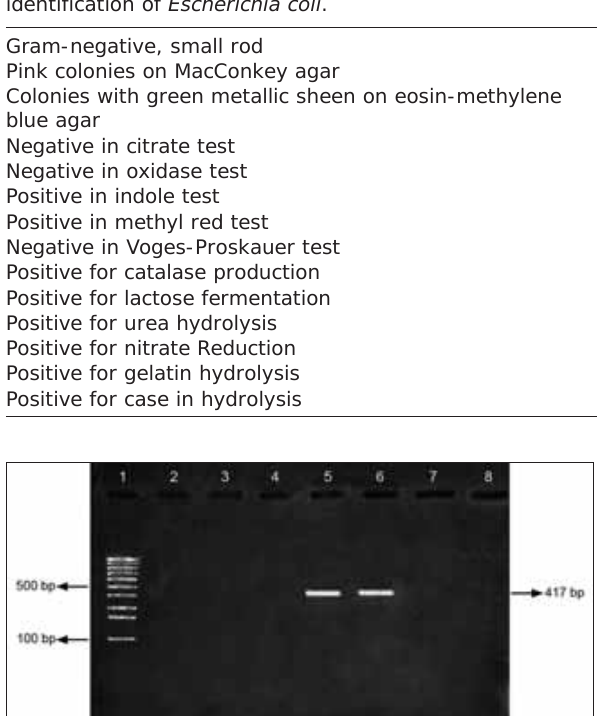
Table-2. In antibacterial susceptibility testing, 21 iso- lates (88%) were resistant to tetracycline antibiotic in disc diffusion method. Out of 24 isolates, 88% were sensitive to cephalexin, 79% to chloramphenicol, 58%